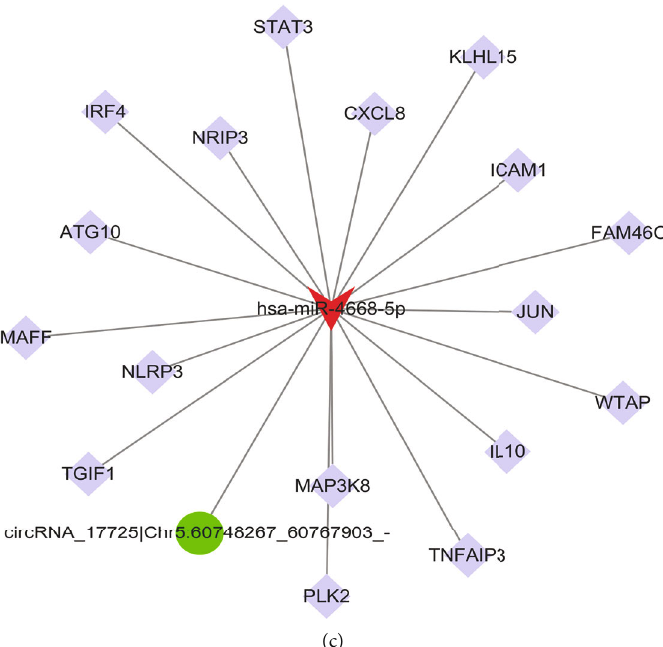
Figure 2: Potential targets prediction of circRNA_17725. (a) Positive coexpression association between circRNA_17725 and FAM46C and other factors implicated by high-throughput sequencing and bioinformatics analysis. (b) Complementary base pairs of circRNA_17725 and miR-4668-5p, plus miR-4668-5p, and FAM46C. (c) A predicted circRNA_17725/miR-4668-5p/FAM46C ceRNA network (the red shape represents miR-4668-5p, the purple squares represent targeted mRNAs including FAM46C, and the green circle represents circRNA_